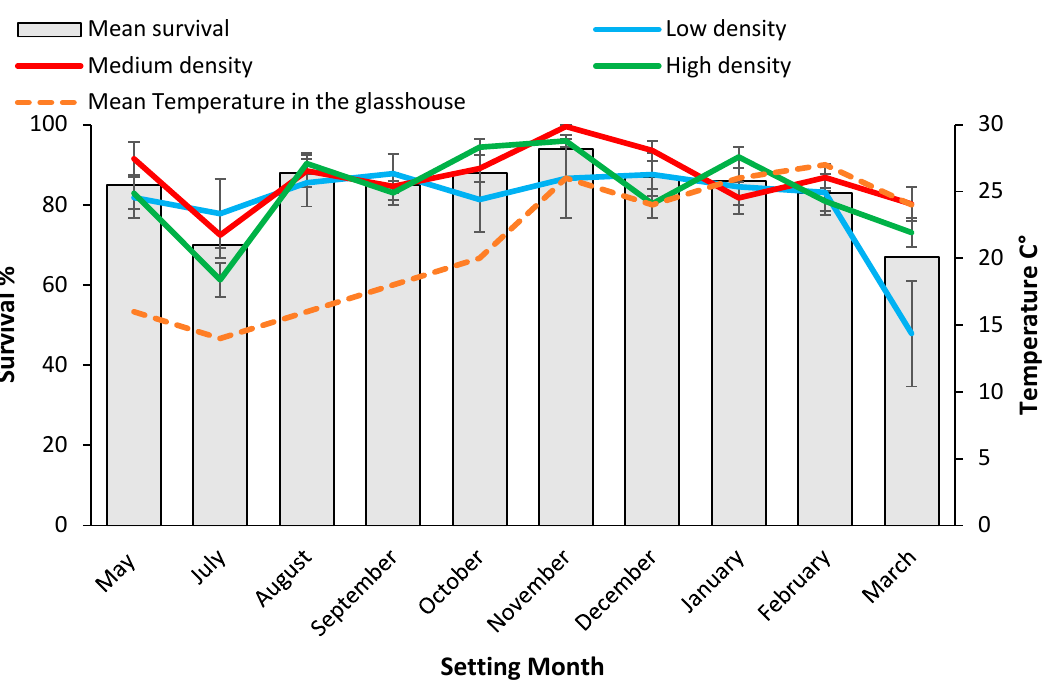
Figure 4. Setting date means for survival rate% 84 days post setting for mini cutting from coir and mean temperature inside the glasshouse during setting months. Values for the mean (pooled over densities) as well as each density level are shown. Bars represent SE.